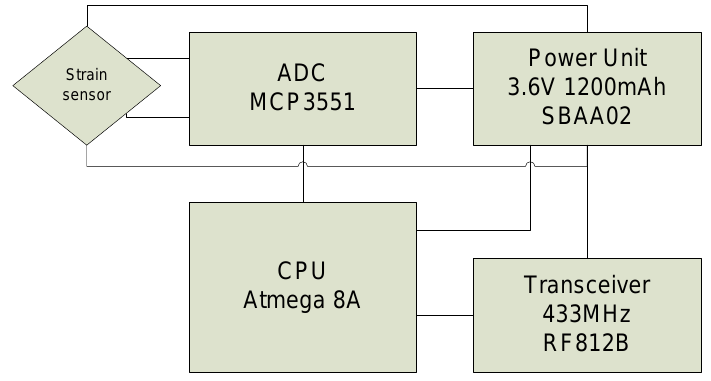
Figure 3. Sensor node structure.